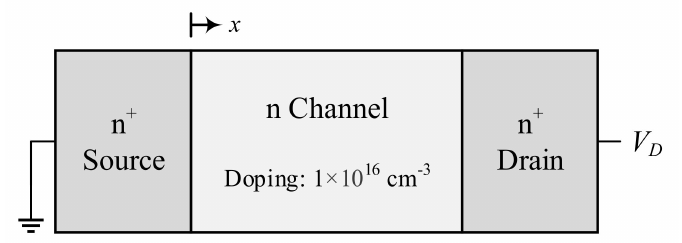
Figure 2. Schematic of the n + nn + device investigated in this study. The source and drain lengths are varied from 20 nm to 150 nm, while the channel length is varied from 2 nm to 120 nm in this